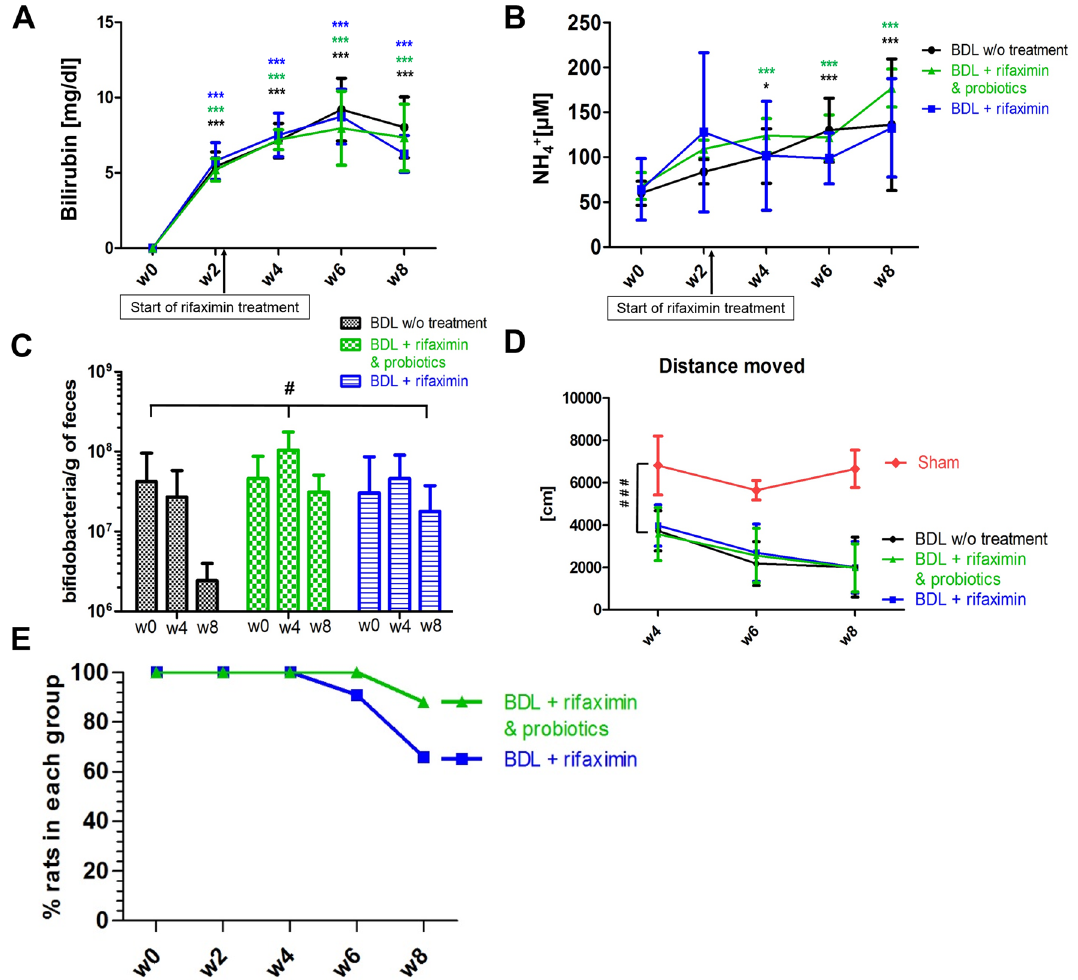
Figure 1. Longitudinal changes in plasma total bilirubin ( A ) and NH 4 + ( B ) in the three groups. In ( A ) and ( B ), statistical significance intra-group (labelled with ‘*’) is shown. ( C ) Bifidobacteria concentration in feces in the three BDL groups. ( D ) Distance traveled by the three groups of BDL and sham-operated rats. In ( C ) and ( D ), the overall statistical significance between-groups (‘treatment’ factor, labelled with ‘#’) is shown. ( E ) Percentage of BDL rats at each week in the ‘rifaximin + probiotics’ group and in the ‘rifaximin’ group. All results are presented as mean ± SD. One-way ANOVA was used to assess the significance intra-group ( A , B ) and two- way ANOVA to assess significance between-groups (‘treatment’ factor; C , D ). Statistical significance: * p < 0.05; ** p < 0.01; *** p <